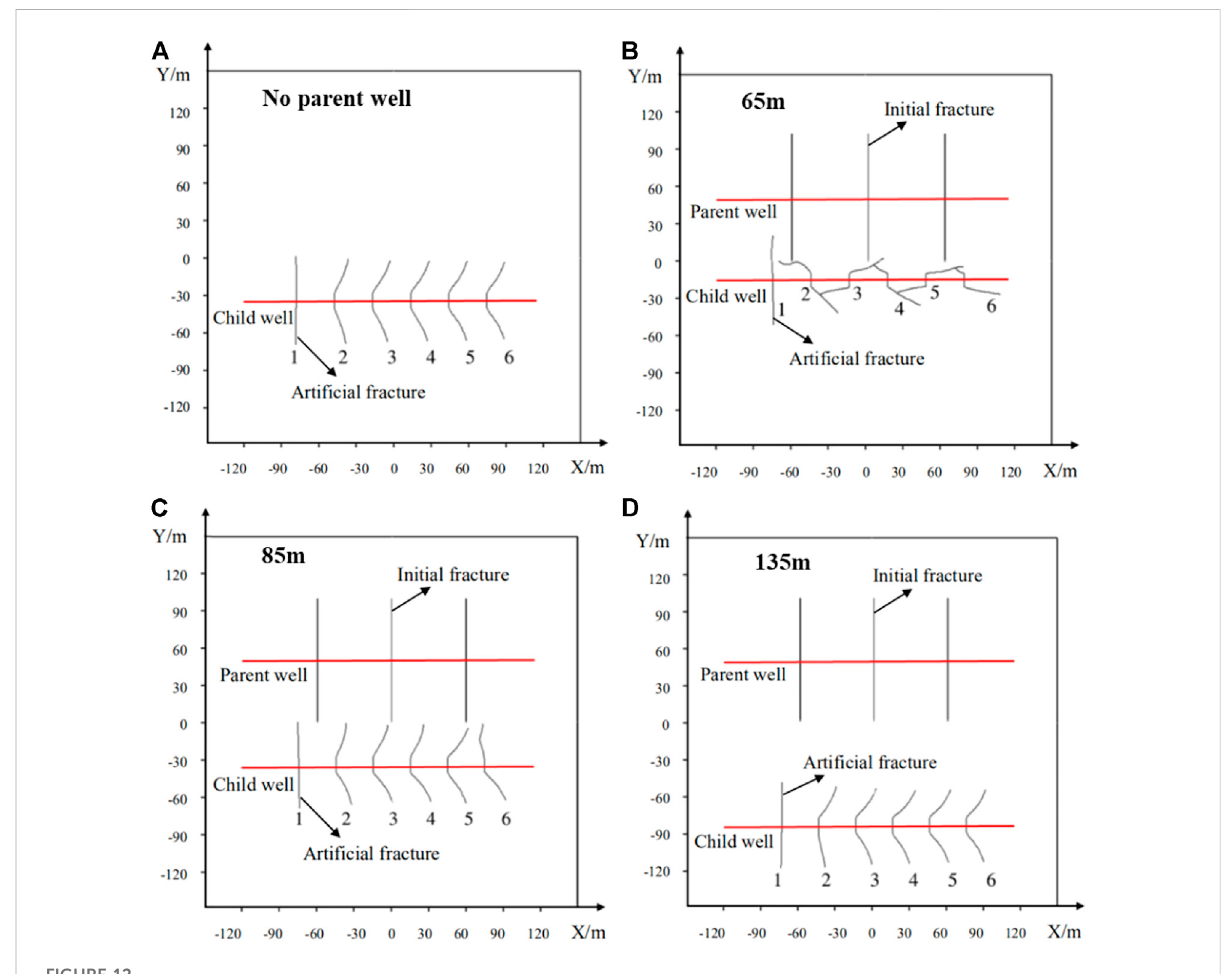
FIGURE 12 Fracture propagation trajectories at different well